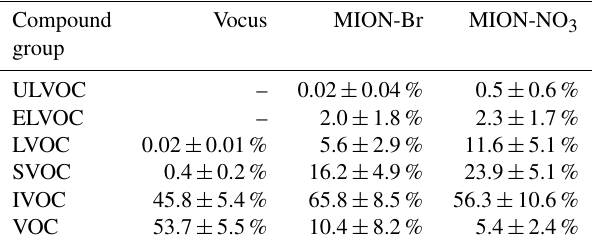
Table 2. Contributions (%, average ± 1 standard deviation) of dif- ferent compound groups to total organics measured by different measurement techniques based on the modified Li et al. (2016) approach (Daumit et al., 2013; Isaacman-VanWertz and Aumont,